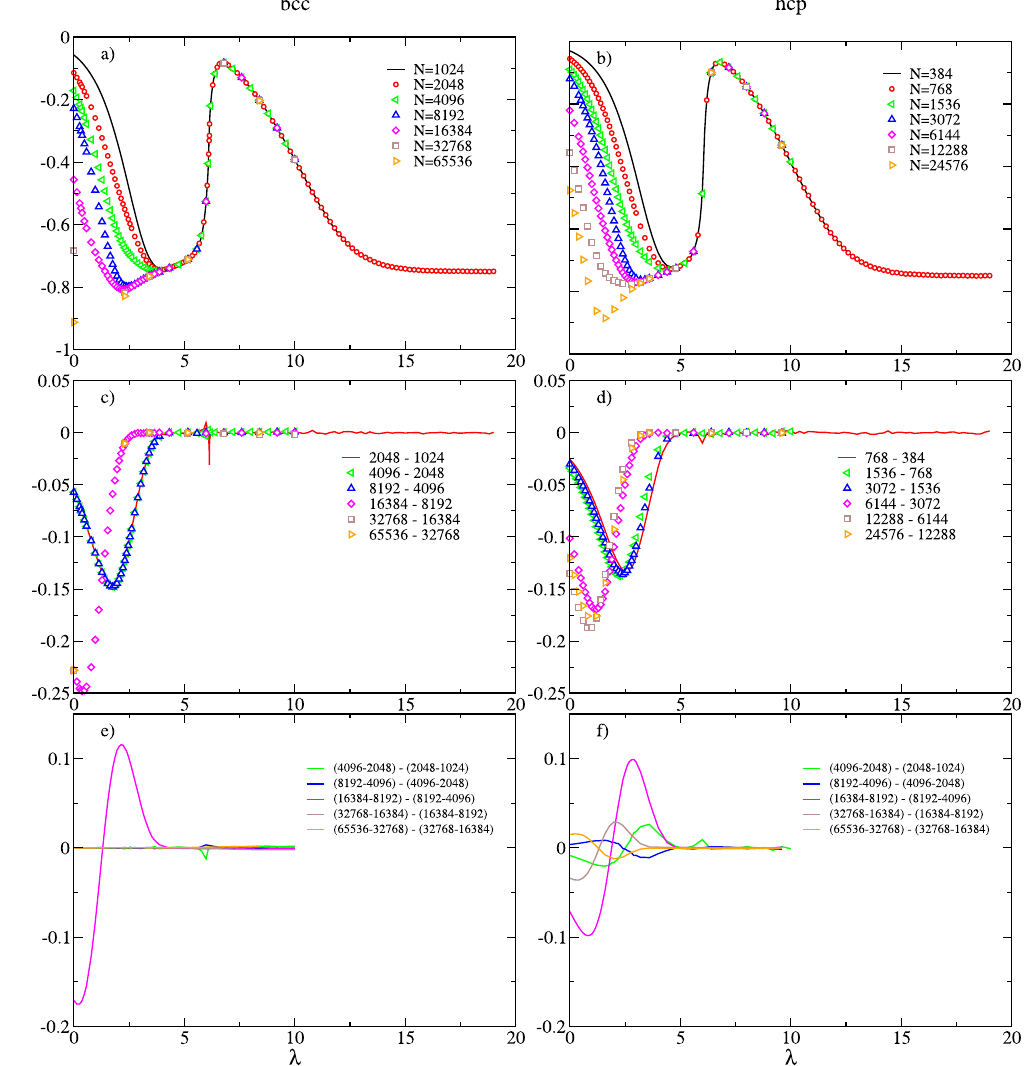
Figure 2. Integrand of equation (12), f ( λ , N ) (top row) and its first and second differences f (1) ( λ , N ) (middle row), and f (2) ( λ , N ) (bottom row), respectively. Note that, according to Eq. (20), only the smallest-system f ( λ , N ) data are integrated (black line in top-row plots), and f (1) ( λ , N ) data are integrated for only the smallest pair of systems (red line in middle-row plots). All f (2) ( λ , N ) are integrated. Lines in each figure join points not represented by symbols (no symbols are joined by